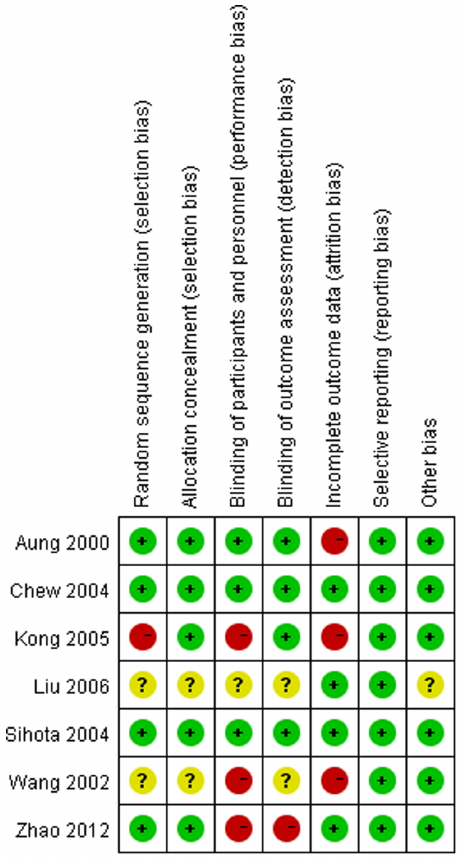
Figure 2. Risk of bias summary. Red stands for high risk of bias, green stands for low risk of bias and yellow stands for unclear risk of